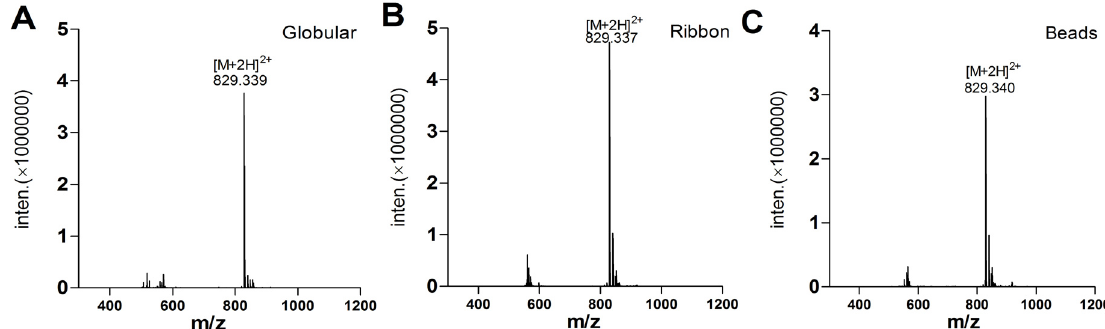
Figure 4. Three synthetic α -CTx TxIA isomers’ mass analyzed by ESI-MS. ( A ) Globular isomer; ( B ) Ribbon isomer; ( C ) Beads